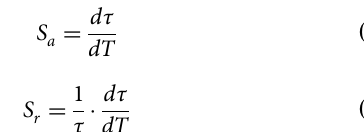
Fig. 6a, where the dependence of lifetime on temperature can be well fi tted by the following equation: